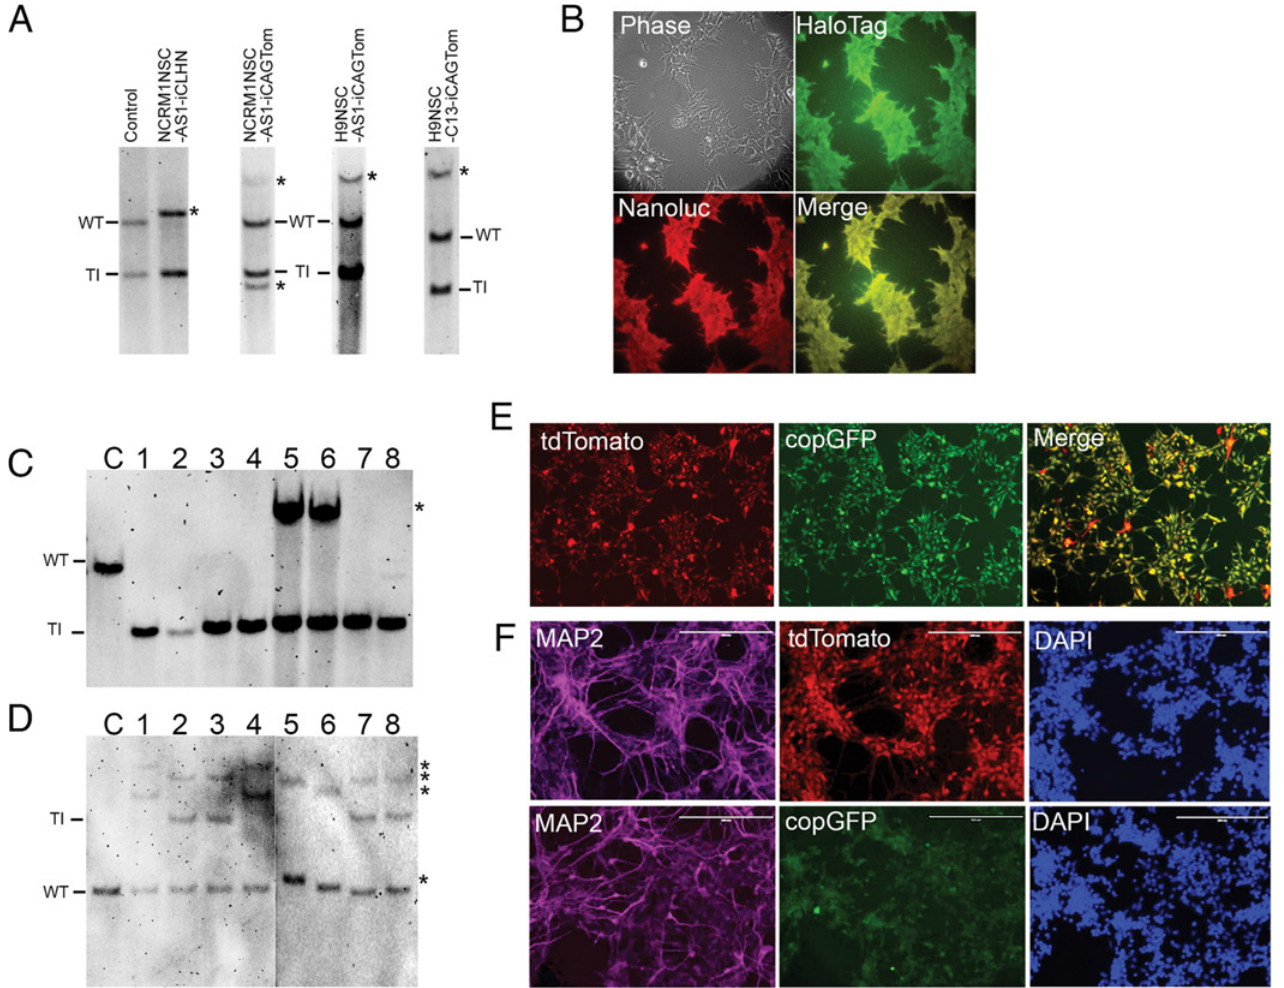
Figure 4. Safe-harbor targeting in human NSCs. (A) Southern analysis of Nanoluc-HaloTag (iCLHN) or tdTomato (iCAGTom) targeted NCRM1NSC or H9NSC at AAVS1 or CLYBL locus using SphI or AvrII digestion, respectively. iPSCs with single TI of iCLHN at AAVS1 allele were used as control. AAVS1 or CLYBL probes used to detect integrations at each safe-harbor are the same as shown in Fig. 4. Compared to the control, NCRM1NSC-AS1-iCLHN shows total loss of wild-type band (WT), indicating that all the cells in the polyclonal NSCs have bi-allelic TI at AAVS1 locus. NCRM1NSCs or H9NSCs targeted by iCAGTom at AAVS1 (AS1), and H9NSCs targeted by iCAGTom at CLYBL (C13) are estimated to have 44%-90% cells correctly targeted without random integrations (S6 Fig.). Asterisk indicates additional RI. (B) Phase, HaloTag fluorescence (stained by Oregon green) and Nanoluc luminescence (pseudo- colored red) images of NCRM1NSC-AS1-iCLHN showed ~100% targeted NSCs express Nanoluc-HaloTag. (C and D) Limiting dilution-derived clones of dual safe-harbor targeted NSCs, NCRM1NSC-AS1Tom-C13GFP, were confirmed by Southern using AAVS1 probe/SphI digestion and CLYBL probe/BamHI digestion as indicated in Fig. 4A. BamHI digestion generates a 11.2kb band due to TI at CLYBL, compared to 4.4kb for WT allele. Note that clone 2, 3, 7 and 8 have bi-allelic AAVS1 TI and mono-allelic CLYBL TI plus an additional RI. Asterisk indicates additional RI. Lane C is control NCRM1NSC. (E and F) Fluorescent images of undifferentiated (E) and differentiated (F) NCRM1NSC-AS1Tom-C13GFP clone 3. MAP2+ committed neurons showed persistent tdTomato and copGFP expression. Nuclei were stained by DAPI. Scale bar = 400 μ m.